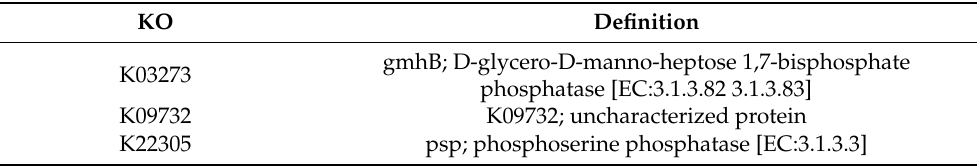
Table 8. KOs that exist in all Gluconacetobacter entanii strains ( n = 9) and do not exist in any Novaceti- monas species ( n = 15).